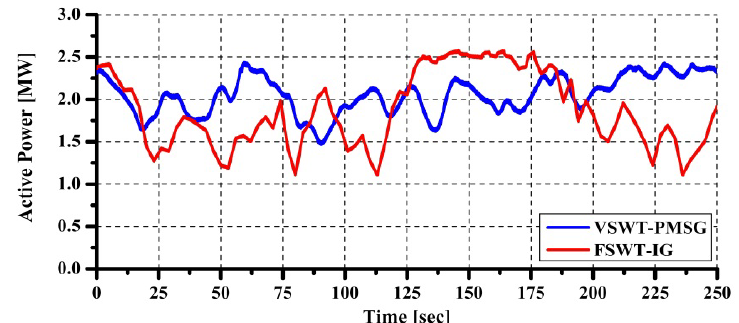
Figure 29. Active power output of wind